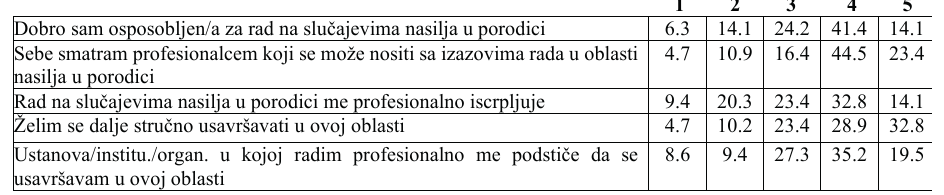
Tabela br. 8: Stepen slaganja sa stavovima, izraženo u postotcima